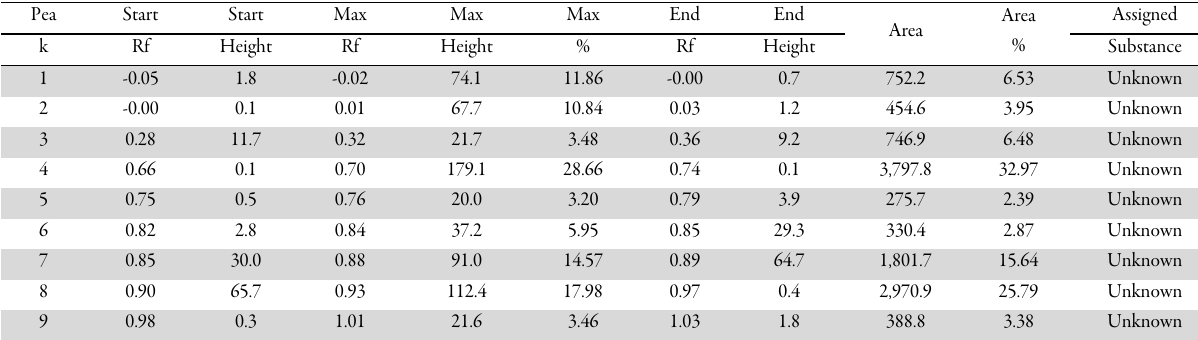
Table 9. HPTLC analysis of ethyl acetate reflux fruit extract Peak